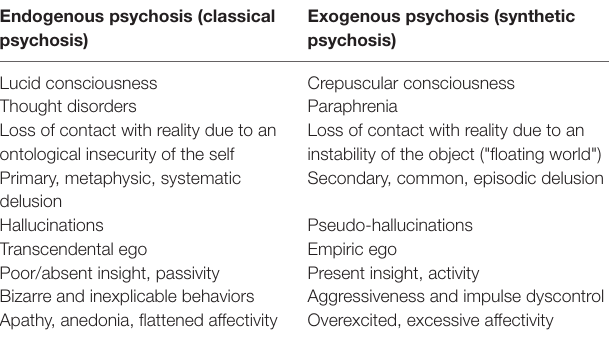
TABLe 3 | Classical psychosis vs. synthetic psychosis: psychopathological and phenomenological profile. endogenous psychosis (classical